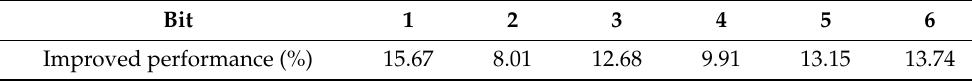
Table 3. Improved performance of adaptive neural networks.